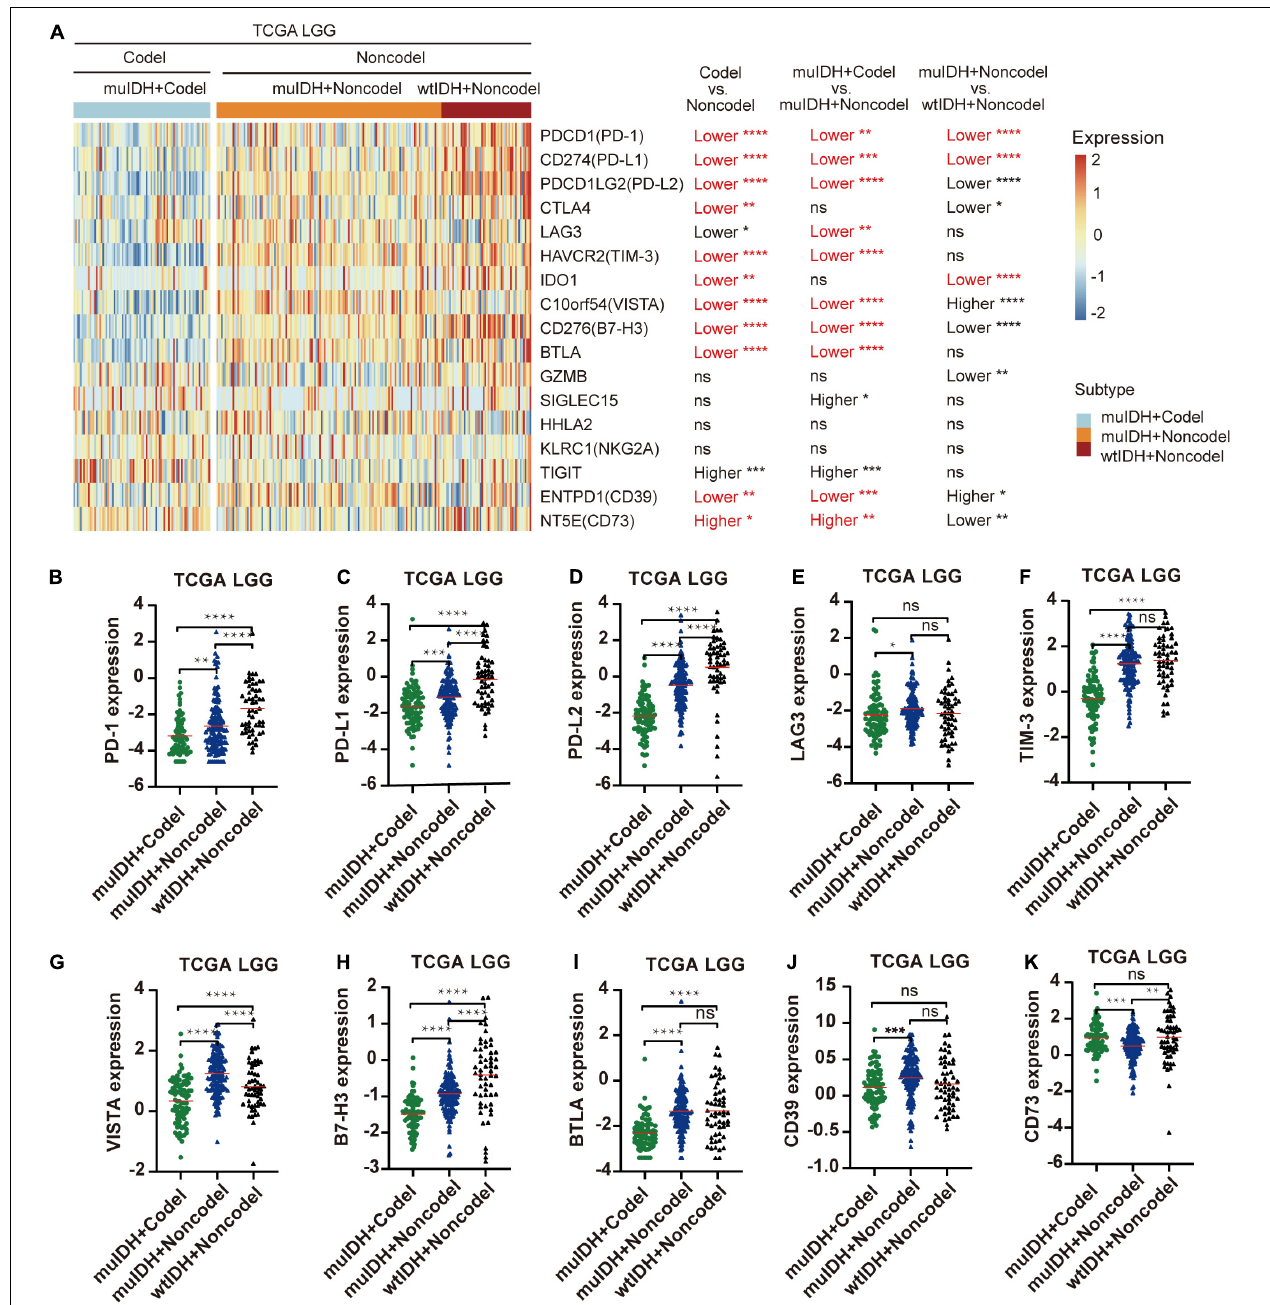
FIGURE 7 | Differentially expressed immune checkpoint genes among different subgroups. (A) The heatmap shows the expression levels of immune-related genes on chromosome 1p/19q among different subgroup LGG patients in TCGA LGG. The significant differences confirmed in both CGGA325 and CGGA693 LGG were marked in red. (B–K) The relative mRNA expression of PD-1 (B) , PD-L1 (C) , PD-L2 (D) , LAG3 (E) , TIM-3 (F) , VISTA (G) , B7-H3 (H) , BTLA (I) , CD39 (J) , and CD73 (K) in TCGA LGG. The mean mRNA expression was indicated by red lines. P values are inferred from a two-sided Student’s t -test or Mann-Whitney test. The number of patients in each subgroup was shown in Figure 1 . * p < 0.05, ** p < 0.01, *** p < 0.001, **** p <